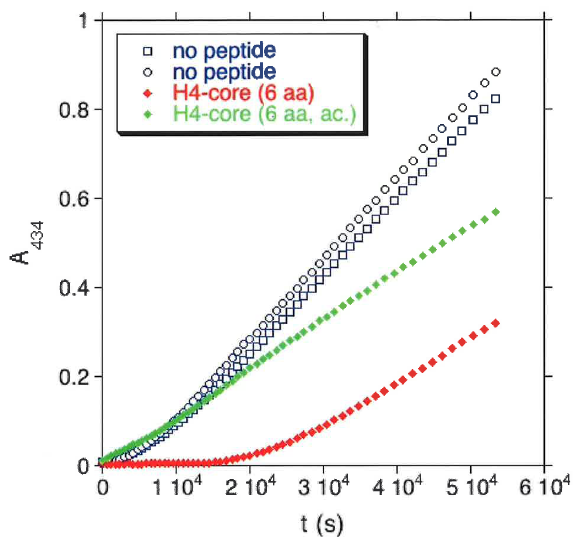
Fig. 4: Absorbance-time (A 434 vs. t) curves of catechin degradation (0.2 mg catechin/mL, 0.69 mM) in the presence of peptides HAKRKT and HAK(ac)RK(ac) each about 1 mg/mL. Further conditions: 20 °C, 0.1 M Tris buffer pH 8 with 3.3% ethanol, 10 mM MgCl 2 (see F eucht et al., 2012 a), and gassed with O 2 ; aa means amino acid, 6 refers to hexapeptide, ac represents acetylated. ing that the blue staining flavanols associate with histones ( P olster et al., 2006) prompted us to study more thoroughly possible links between the chromatin activity and patterning of flavanols. Recent studies with hemlock ( Tsuga canadensis) indicated that the blue coloured flavanol landscape from activated chromatin is organized as a mosaic-like structure being quite different from the evenly